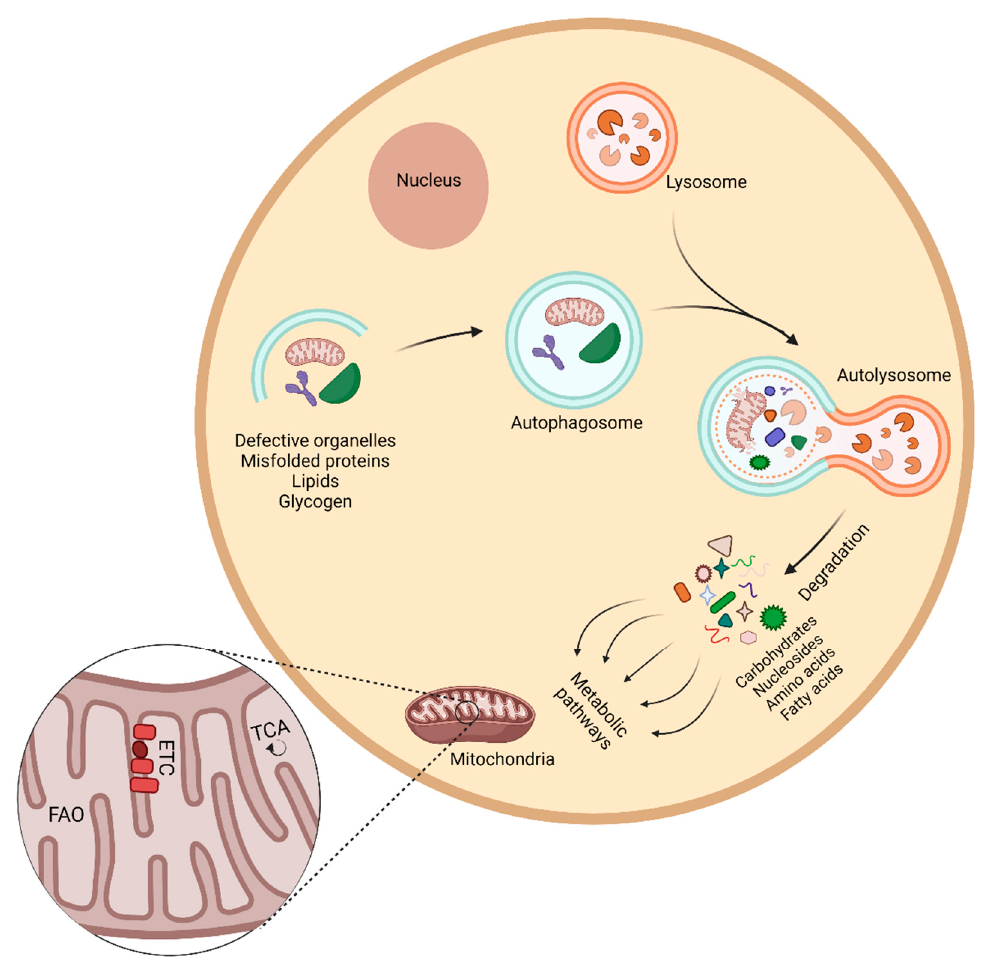
Figure 3. Autophagy and cell metabolism in cancer. Autophagy plays an important role in removing defective cellular organelles and macromolecules and recycling them for further use in different metabolic pathways. Mitochondria are the primary cellular organelles responsible for various cellular metabolic pathways including fatty acid oxidation (FAO), the tricarboxylic acid (TCA) cycle, and the electron transport chain (ETC). Impaired production of metabolic intermediates important for cellular proliferation can lead to a metabolic crisis and subsequently limit tumor growth. Conversely, excessive production of reactive oxygen species and the resultant oxidative damage can lead to